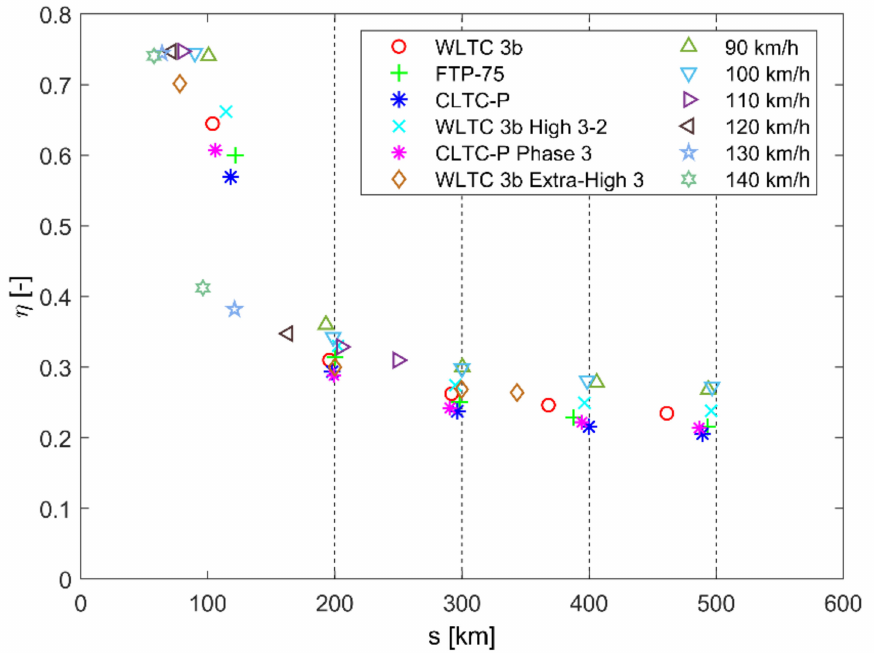
Figure A14. Efficiency results for BEV mode and EREV drive (four EREV range targets indicated with dashed vertical lines) in various drive cycle conditions. Vehicle mass is equal to 2100 kg.